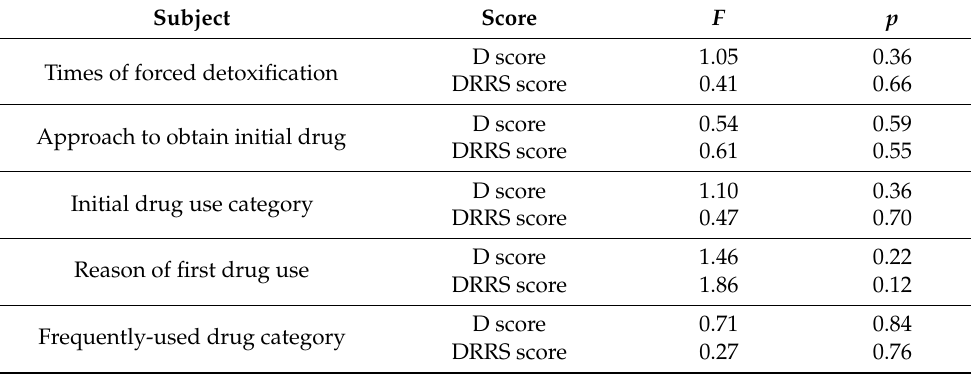
Table 8. Results of one-way ANOVA.